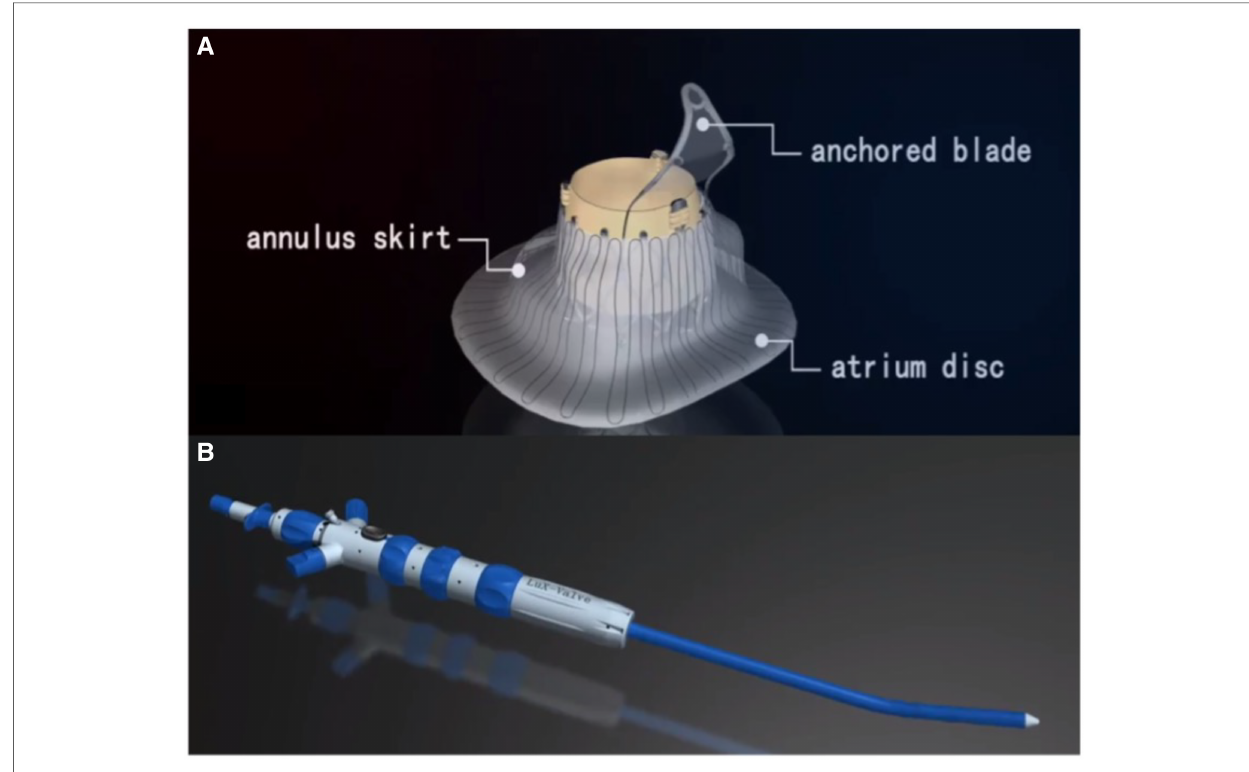
FIGURE 2 Introduction of LuX-valve. ( A, B ) LuX-valve (Ningbo Jenscare Biotechnology, Ningbo, China) consists of a biological valve stent, three valve lobules, and a steerable delivery system. The bioprosthesis is implanted via the RA approach and fi xed in the TA with its own unique anchoring device, independent of the radial support force. It consists of an atrium disc, annulus skirt and anchored